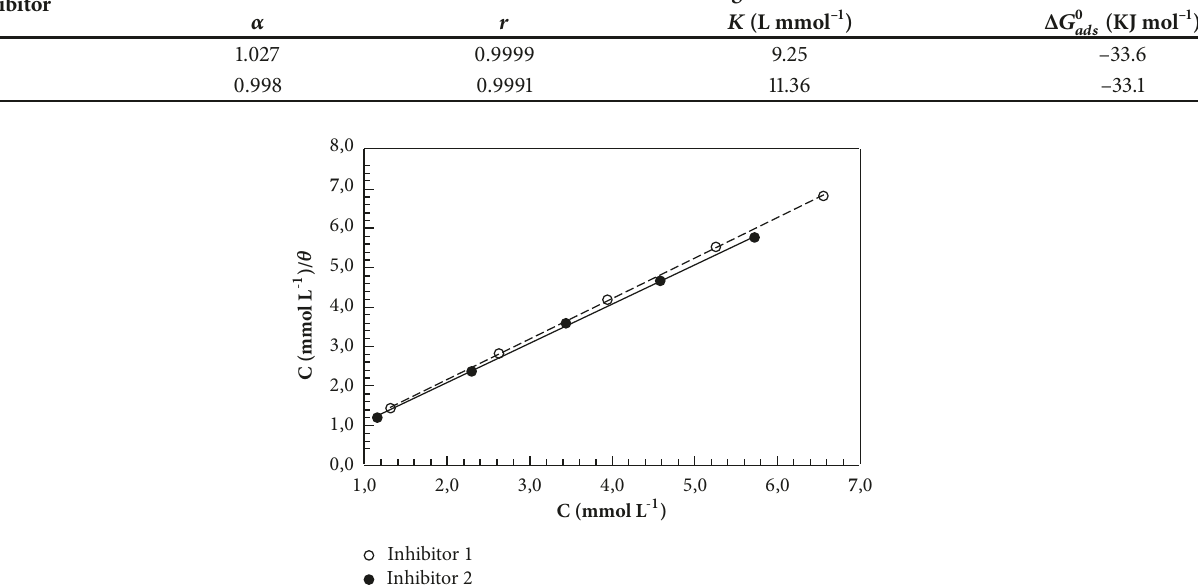
Table 4: Values of the 𝛼 and 𝑟 of the Langmuir isotherm, 𝐾 , and (cid:2) 𝐺 0 𝑎𝑑𝑠 obtained for the corrosion inhibitors. Inhibitor